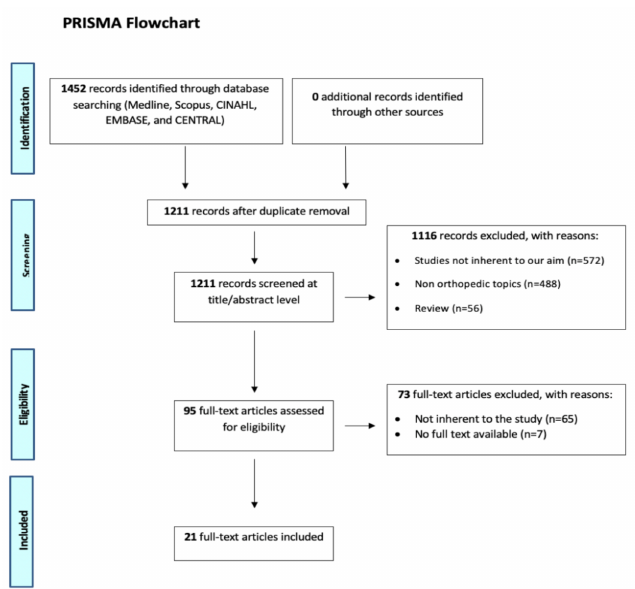
Figure 1. Study selection process and screening according to the Preferred Reporting Items for Systematic reviews and Meta-Analyses (PRISMA) flow chart